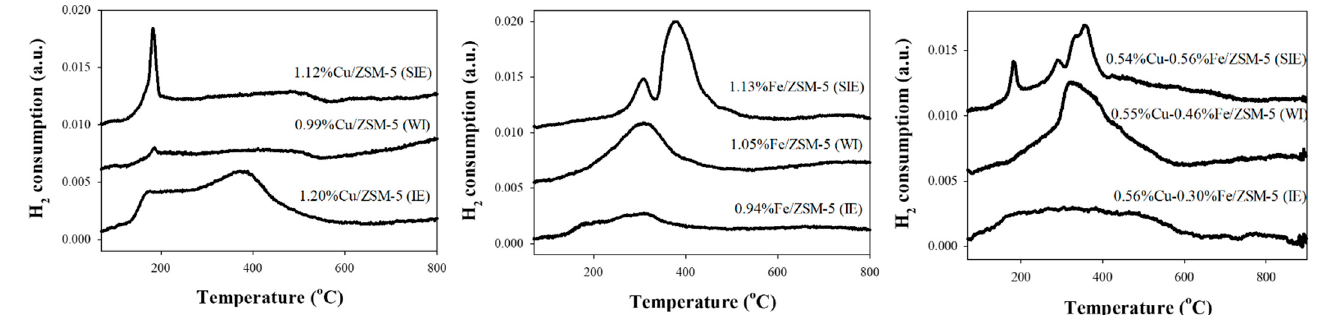
Figure 2. H 2 -TPR pattern of the catalysts prepared with different methods. To elucidate the Fe and Cu species in each catalyst, the IR spectra were obtained after NO adsorption. As shown in Figures 3 and S5, two IR peaks were observed at 1810 and 1910 cm − 1 for Cu/ZSM-5(IE). An IR peak at 1910 cm − 1 was also observed for Cu/ZSM-5(WI) and Cu/ZSM-5(SIE), but the peak intensity was attenuated compared to that of Cu/ZSM-5(IE). Interestingly, no noticeable IR peak at 1810 cm − 1 were observed for Cu/ZSM-5(WI) and Cu/ZSM-5(SIE). In the case of Fe/ZSM-5, two typical IR peaks with different intensities were observed at 1810 and 1880 cm − 1 for all catalysts. The decreasing peak intensity order was Fe/ZSM-5(IE) > Fe/ZSM-5(WI) > Fe/ZSM-5(SIE). The IR peaks observed for Cu/ZSM-5 and Fe/ZSM-5 were also observed for Cu-Fe/ZSM-5. The descending order of peak intensities at 1810 and 1880 cm − 1 was: Cu-Fe/ZSM-5(IE) > Cu-Fe/ZSM-5(WI) > Cu-Fe/ZSM-5 (SIE). In contrast, at 1910 cm − 1 the decreasing peak intensity order was: Cu-Fe/ZSM-5(IE), Cu-Fe/ZSM-5(SIE), and Cu-Fe/ZSM-5 (WI). FT-IR spectra after NO chemisorption have frequently been used to probe the surface Cu and Fe species in zeolites. The band at 1880 cm − 1 , which is due to Fe 2+ -(NO) ( γ -position), has been reported to be an active Fe species [48–53]. Previous studies regarding Cu/ZSM-5 [44,54–56] have indicated that the 1910 and 1810 cm − 1 bands are a result of Cu 2+ -(NO) and Cu + -(NO), respectively. Figure 3 shows that Cu/ZSM-5(IE) had dominant Cu + -(NO) and Cu 2+ -(NO), in contrast with those Cu/ZSM-5(WI) and Cu/ZSM-5(SIE). The Cu + observed in Cu/ZSM-5(IE) can be formed through the auto-reduction of Cu 2+ , which has been frequently reported in previous EPR and IR studies [54–56]. The band at 1880 cm − 1 might be ascribed to Cu 2+ -(NO), which has been reported to occur when the Cu/Al ratio is elevated in Cu/ZSM-5 content (Cu/Al > 0.5) [44,55]. However, because Cu/ZSM-5 has a very low Cu/Al ratio of 0.2, the band at 1880 cm − 1 observed for Cu-Fe/ZSM-5 is due to Fe 2+ -(NO) and not Cu 2+ -(NO). The band at 1910 cm − 1 may be due to the presence of Fe 2+ -(NO) 2 species. However, this band was not observed for Fe/ZSM-5 catalysts. Therefore, the band at 1910 cm − 1 is due to Cu 2+ -(NO). Among the Cu-Fe/ZSM-5 catalysts, Cu-Fe/ZSM-5(IE) showed the largest bands at 1810, 1880, and 1910 cm − 1 . Consequently, the IE method is the most effective method for dispersing Cu 2+ and Fe 2+ species in